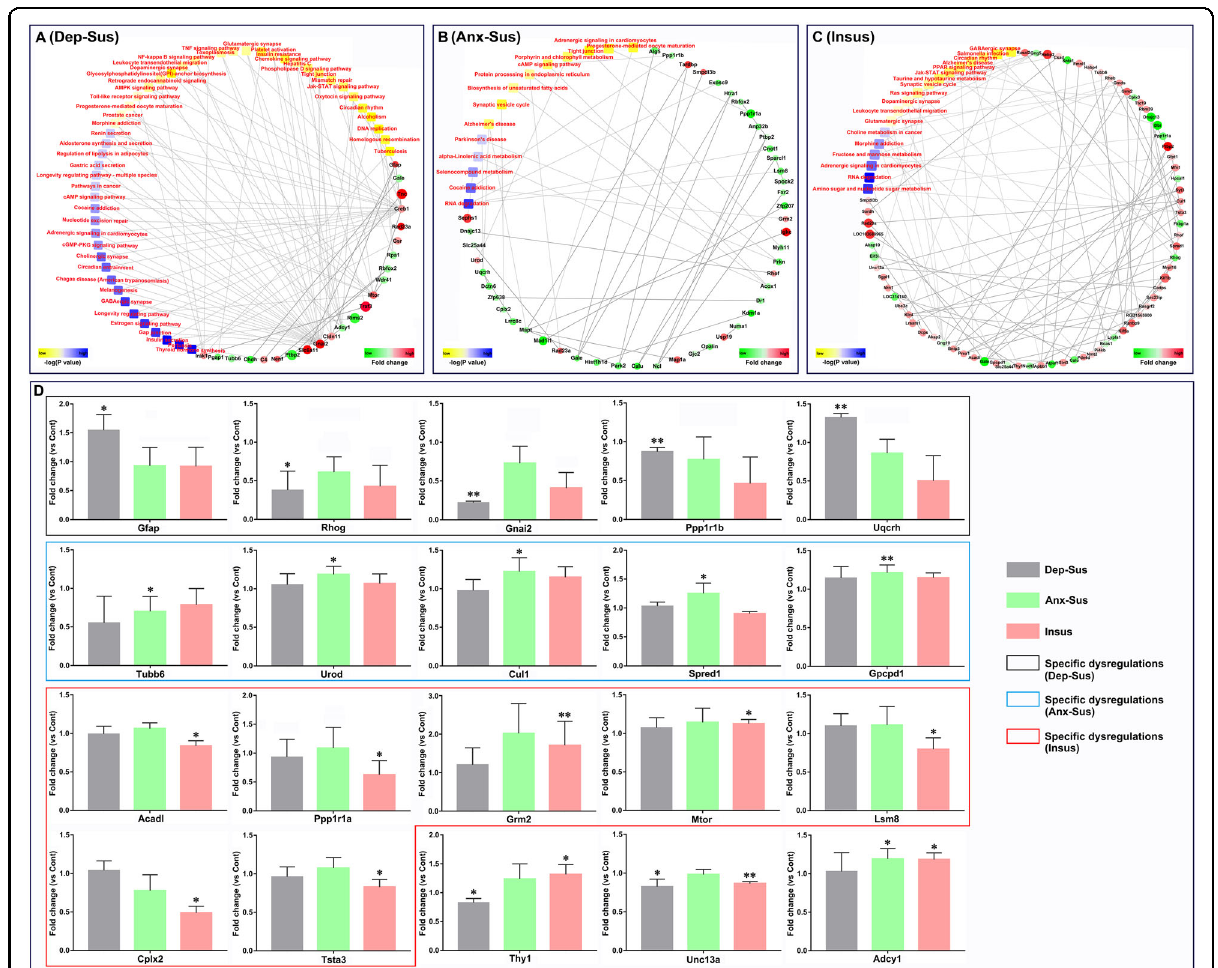
Fig. 5 Protein – protein interaction and parallel reaction monitoring analyses of the differentially expressed proteins. The protein – protein interaction (PPI) networks of the three groups (depression-susceptible (Dep-Sus, A ), anxiety-susceptible (Anx-Sus, B ), and insusceptible (Insus, C )) were constructed based on protein alterations and Kyoto Encyclopedia of Genes and Genomes (KEGG) pathway term enrichments. Proteins/genes were represented by circular nodes. The KEGG pathway is indicated by the rectangle, shaded based on the p value. Higher p value is shown in yellow and lower p value in blue. D Parallel reaction monitoring (PRM) analysis of the differentially expressed proteins in the Dep-Sus, Anx-Sus, and Insus groups relative to the control (Cont). Gfap, Rhog, Gnai2, Ppp1r1b, Uqcrh, Tubb6, Urod, Cul1, Spred1, Gpcpd1, Acadl, Ppp1r1a, Grm2, Mtor, Lsm8, Cplx2, Tsta3, Thy1, Unc13a, and Adcy1 were detected on the prefrontal cortical protein extracts of the rats; n = 4 – 5, * p < 0.05, ** p <